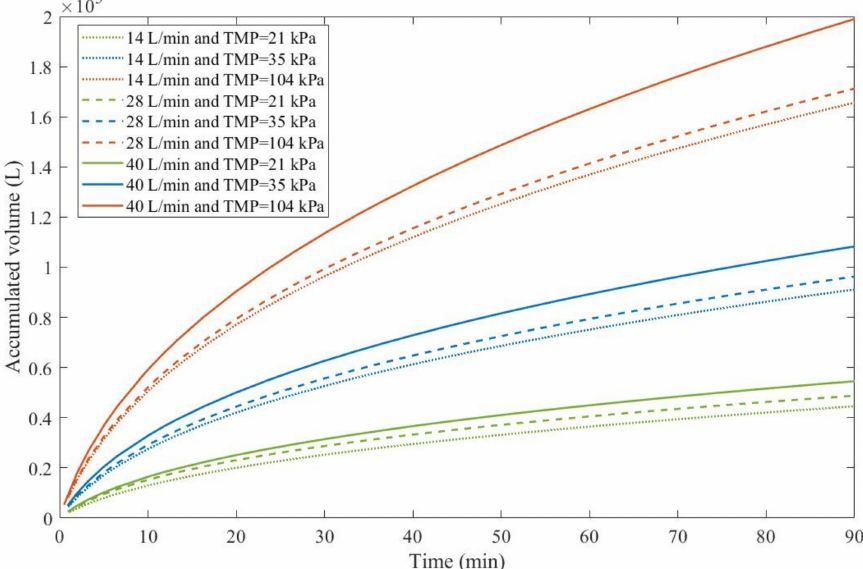
Figure 3. The accumulated volume calculated through the EHM for oily effluent ultrafiltration with CFR of 14–40 L/min and 21–104 kPa, assuming A = 1.00 m 2 . Example 4. Model fitting for ultrafiltration of alkali/surfactant/polymer flooding wastewater.